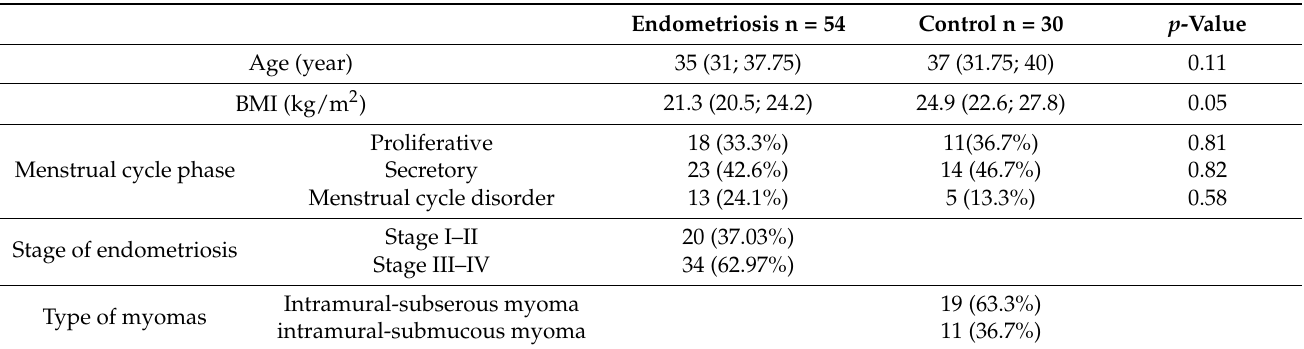
Table 1. The clinical characteristics of the study groups.